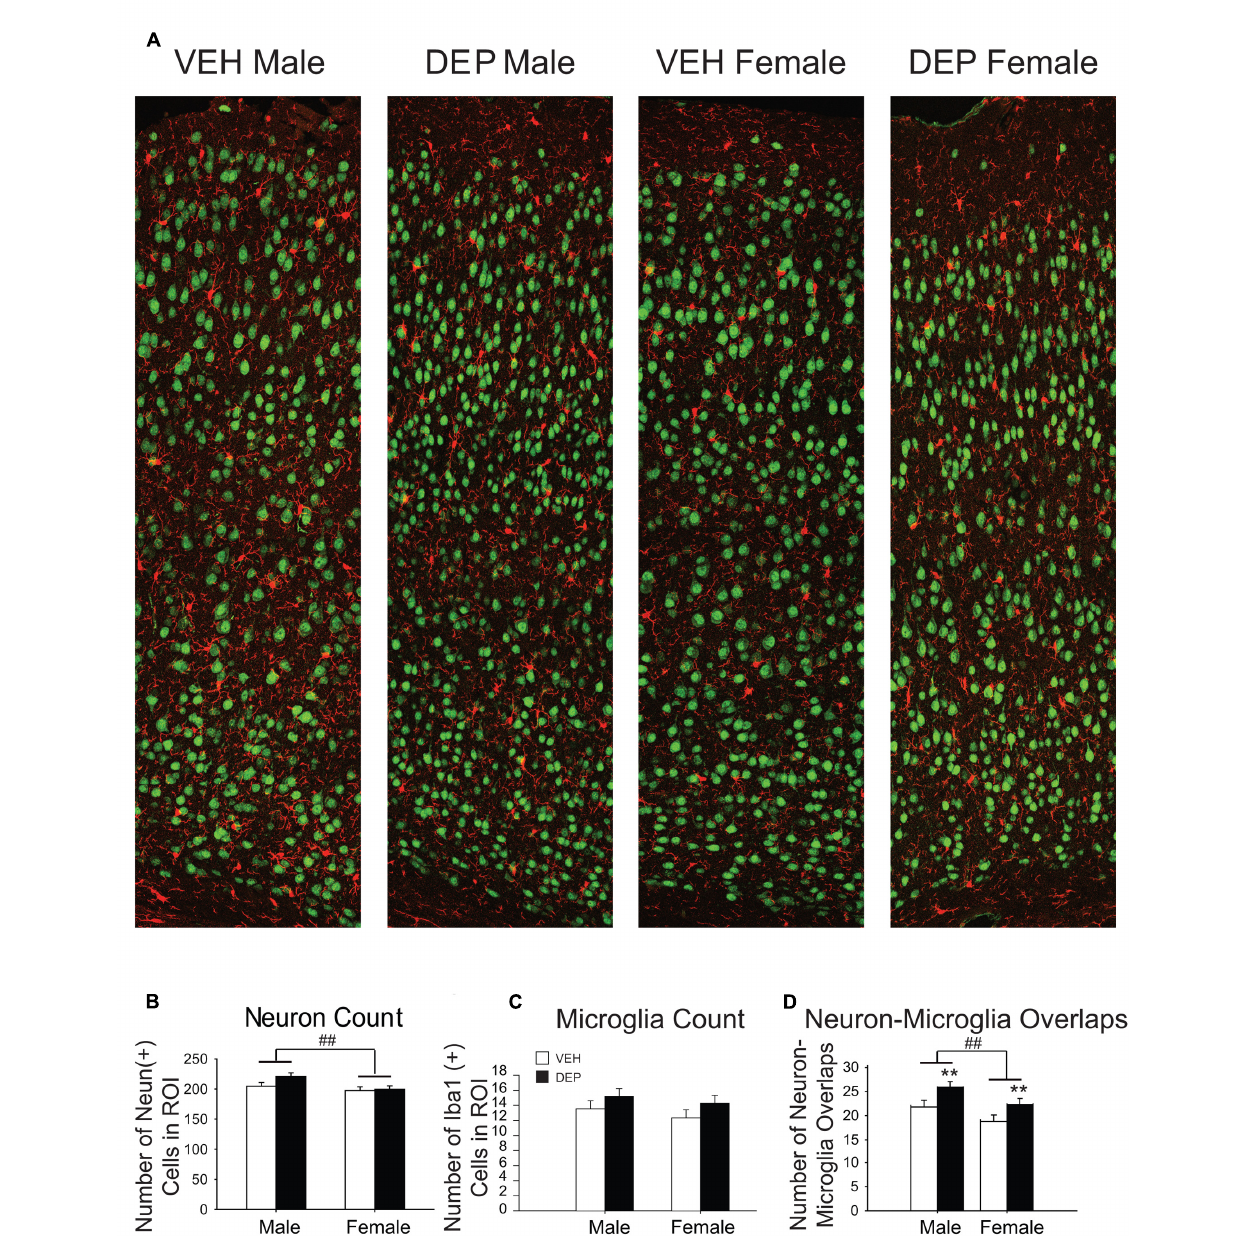
FIGURE 3 | Prenatal DEP exposure alters microglia-neuron interaction frequency but not neuron or microglia number in the parietal cortex of P30 offspring. (A) Representative panoramic images of microglia (Iba1, red) and neurons (NeuN, green) in the parietal cortex of P30 offspring taken at 40 × magnification and stitched together with 30% overlap. (B) Neuron Quantification. Males have significantly more NeuN+ cells than females. (C) Microglia Quantification. The numbers of Iba1+ cells do not differ by Sex, DEP exposure or the interaction of the two. (D) Microglia-Neuron Interaction Quantification. Males have significantly more overlaps between microglia and neurons than females, and DEP-treated animals have significantly more overlaps than those treated with VEH. Bar graphs represent mean values ± SEM (error bars); n = 6 mice/group, average of 3 brain sections per mouse. ## p < 0.05, males vs. females; ∗∗ p < 0.05, DEP vs.